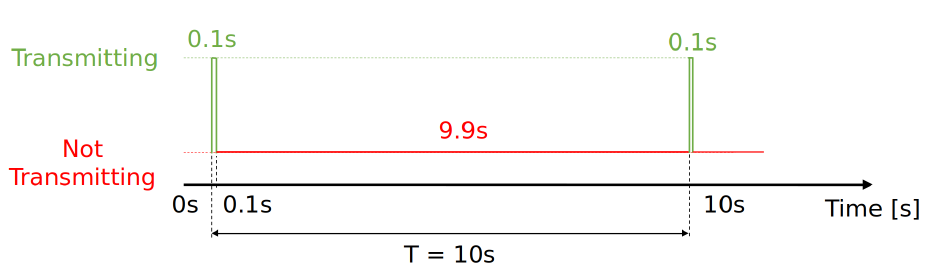
Figure 13. Schema representing behaviour of device respecting a duty-cycle of